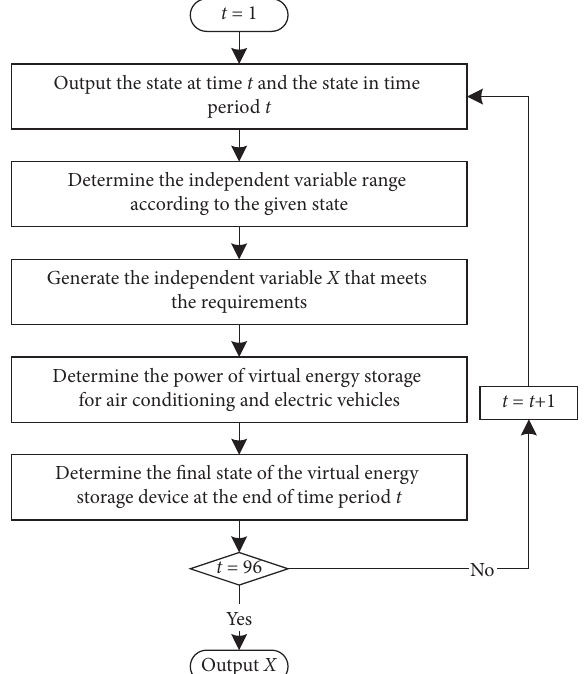
Figure 4: Flowchart of virtual energy storage capacity and output power rolling